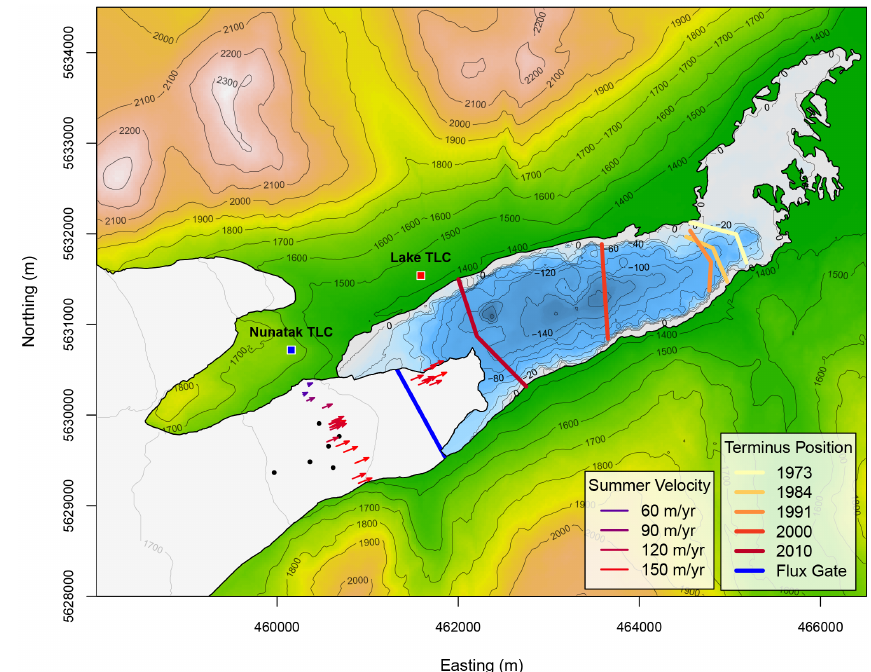
Figure 5. Map showing 2013 Bridge Lake bathymetry, 2013 study period flow vectors (velocity in myr − 1 at scale of the map), abla- tion/velocity stakes (black dots), flux gate, and historical terminus